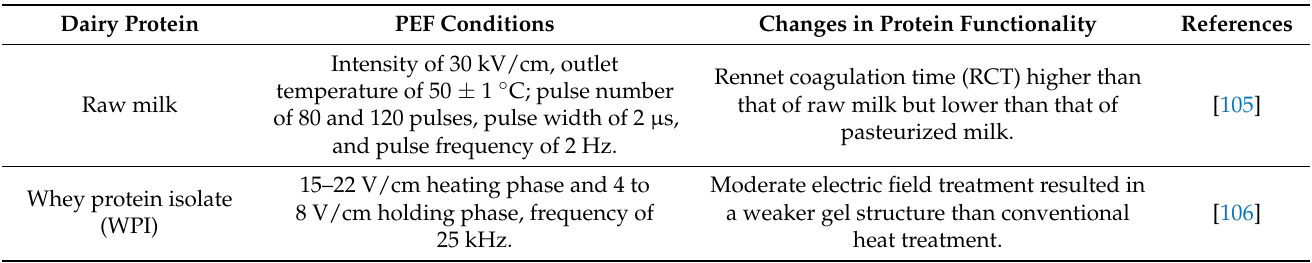
Table 5. Effects of pulsed electric field (PEF) on the techno-functional properties of dairy proteins. Dairy